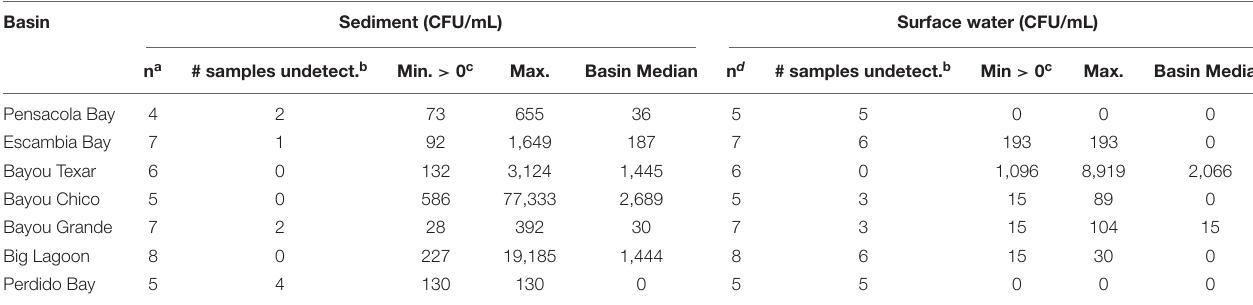
( Table 5 ). Water Vv abundances were also positively correlated with bottom water pH ( r = 0.46, p < 0.05) and tidal coefficient ( r = 0.86, p < 0.01) and moderately correlated with average sediment chl a concentrations ( r = 0.29, p = 0.057) ( Table 5 ). Surface water Vv did not covary strongly with salinity. Surface water Vp abundances correlated with seven parameters, the greatest number of correlations among the four calculated species abundances. Parameters that showed negative correlations with surface water Vp included surface salinity ( r = − 0.36, p < 0.05), surface pH ( r = − 0.45, p < 0.05), and bottom pH ( r = −